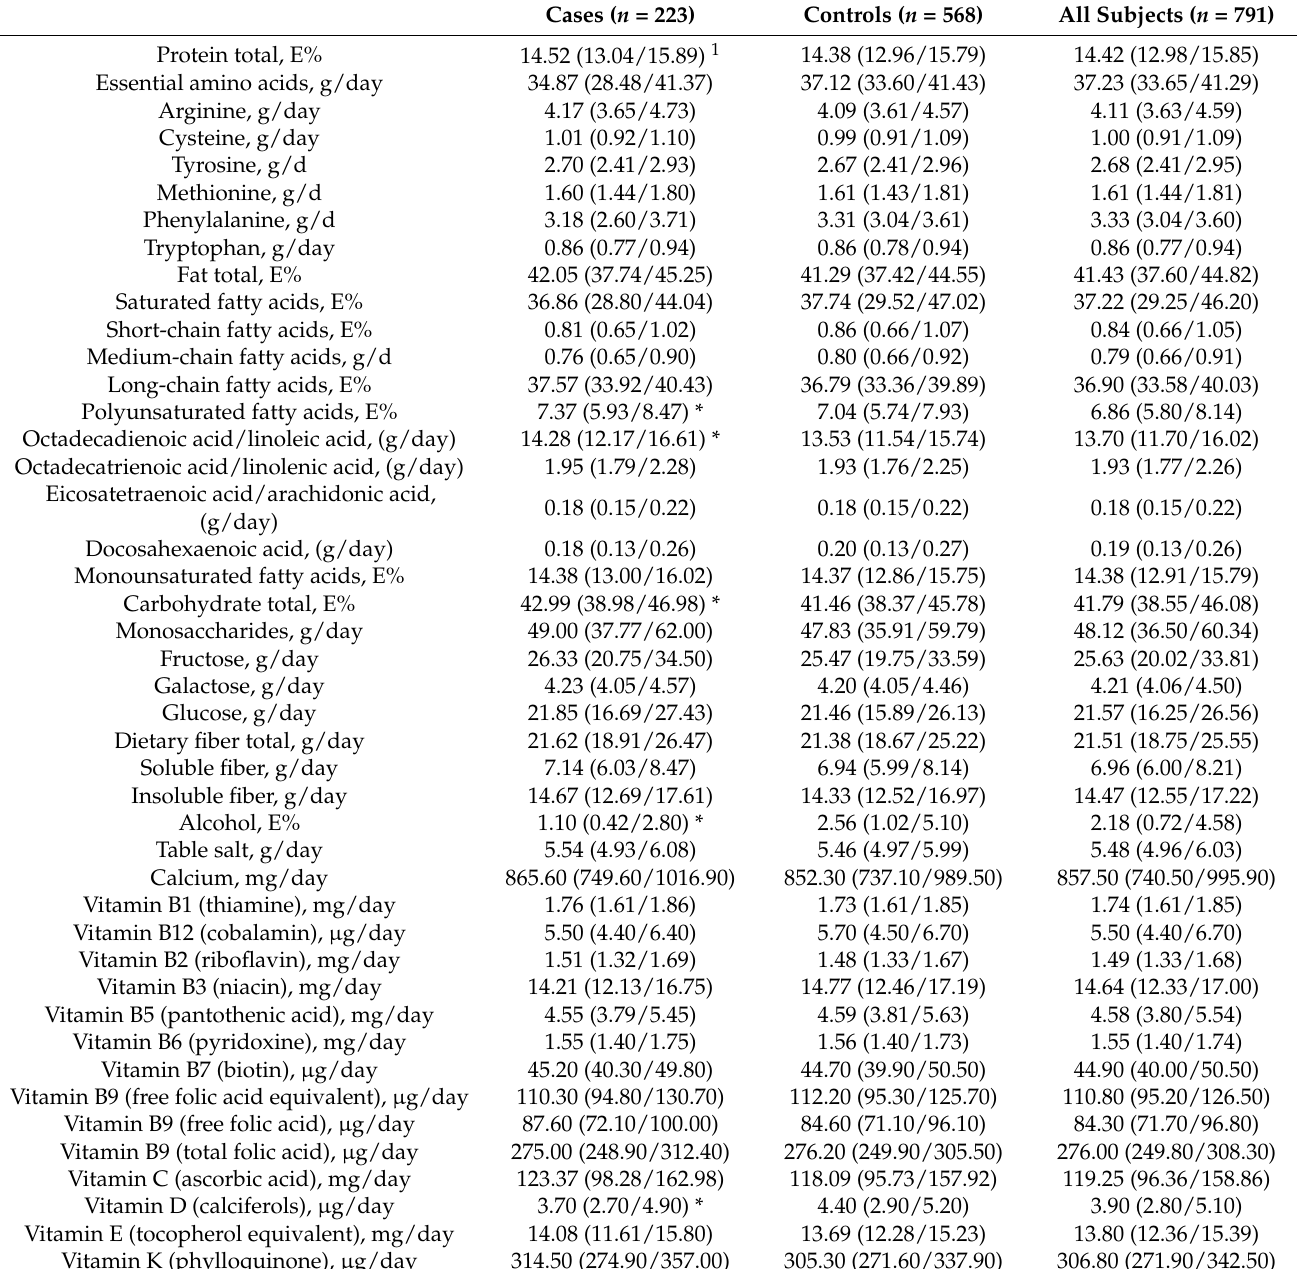
Table 2. Characterization of energy adjusted macro- and micronutrient intake between the